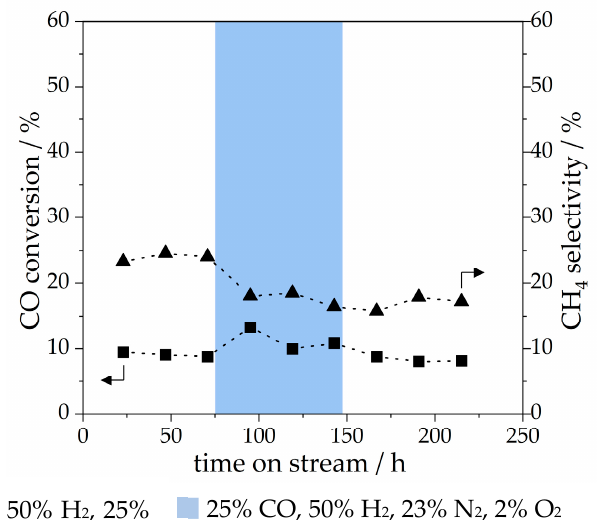
25% CO, 50% H 2 , 23% N 2 , 2% O 2 25% CO, 50% H 2 , 25%